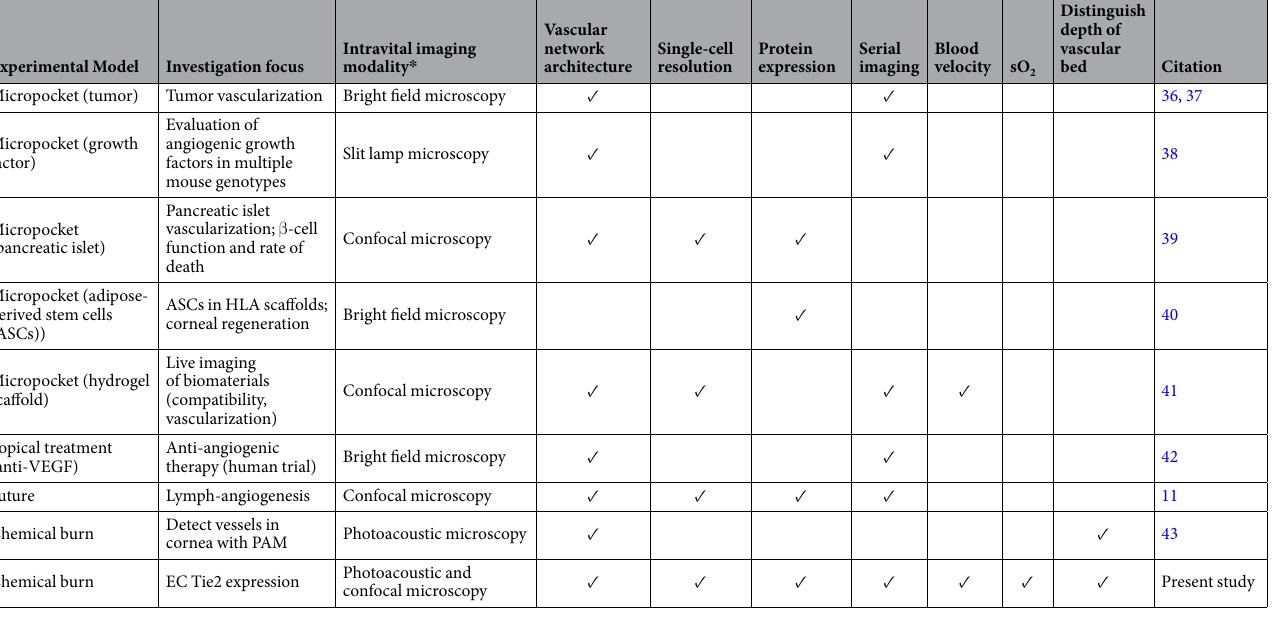
Table 1. Models of In Vivo Corneal Angiogenesis. * Used at the highest